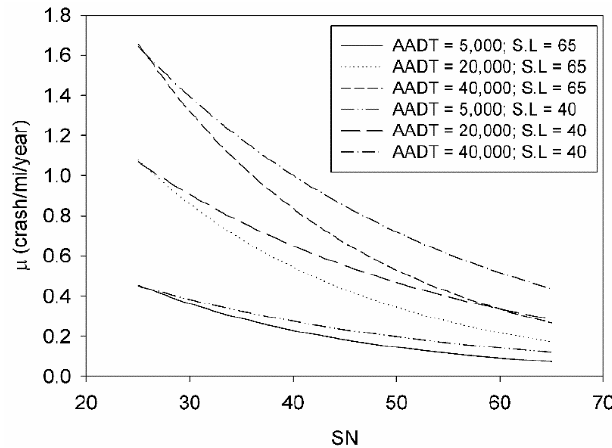
( b ) Figure 7. Expected crash rates as a function of SN, AADT, and SL; as explained by the NB regression models for ( a ) dry and ( b ) wet environmental surface conditions.